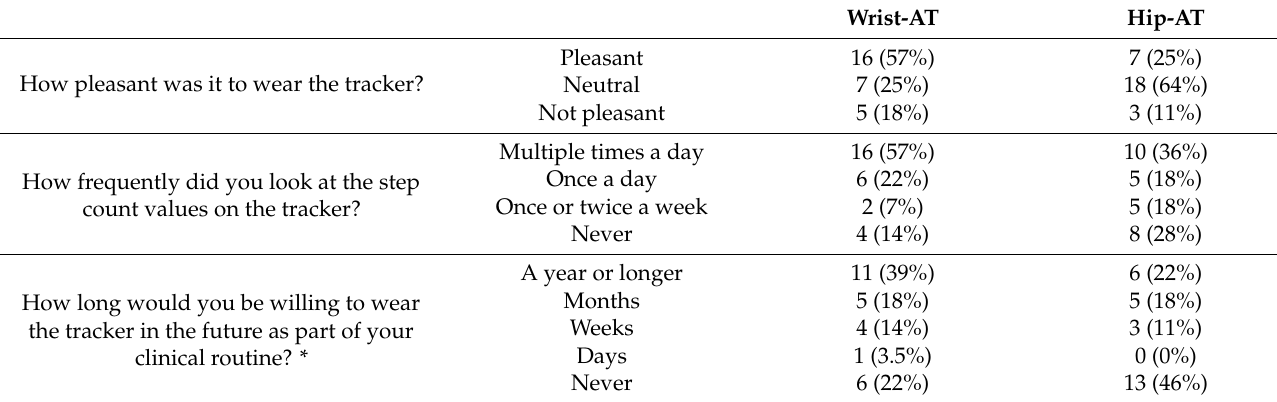
Table 4. User experiences in PwPD.